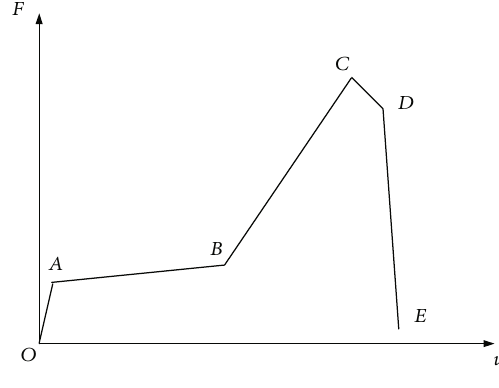
Figure 5: Four-stage dividing sketch of load-displacement curves.